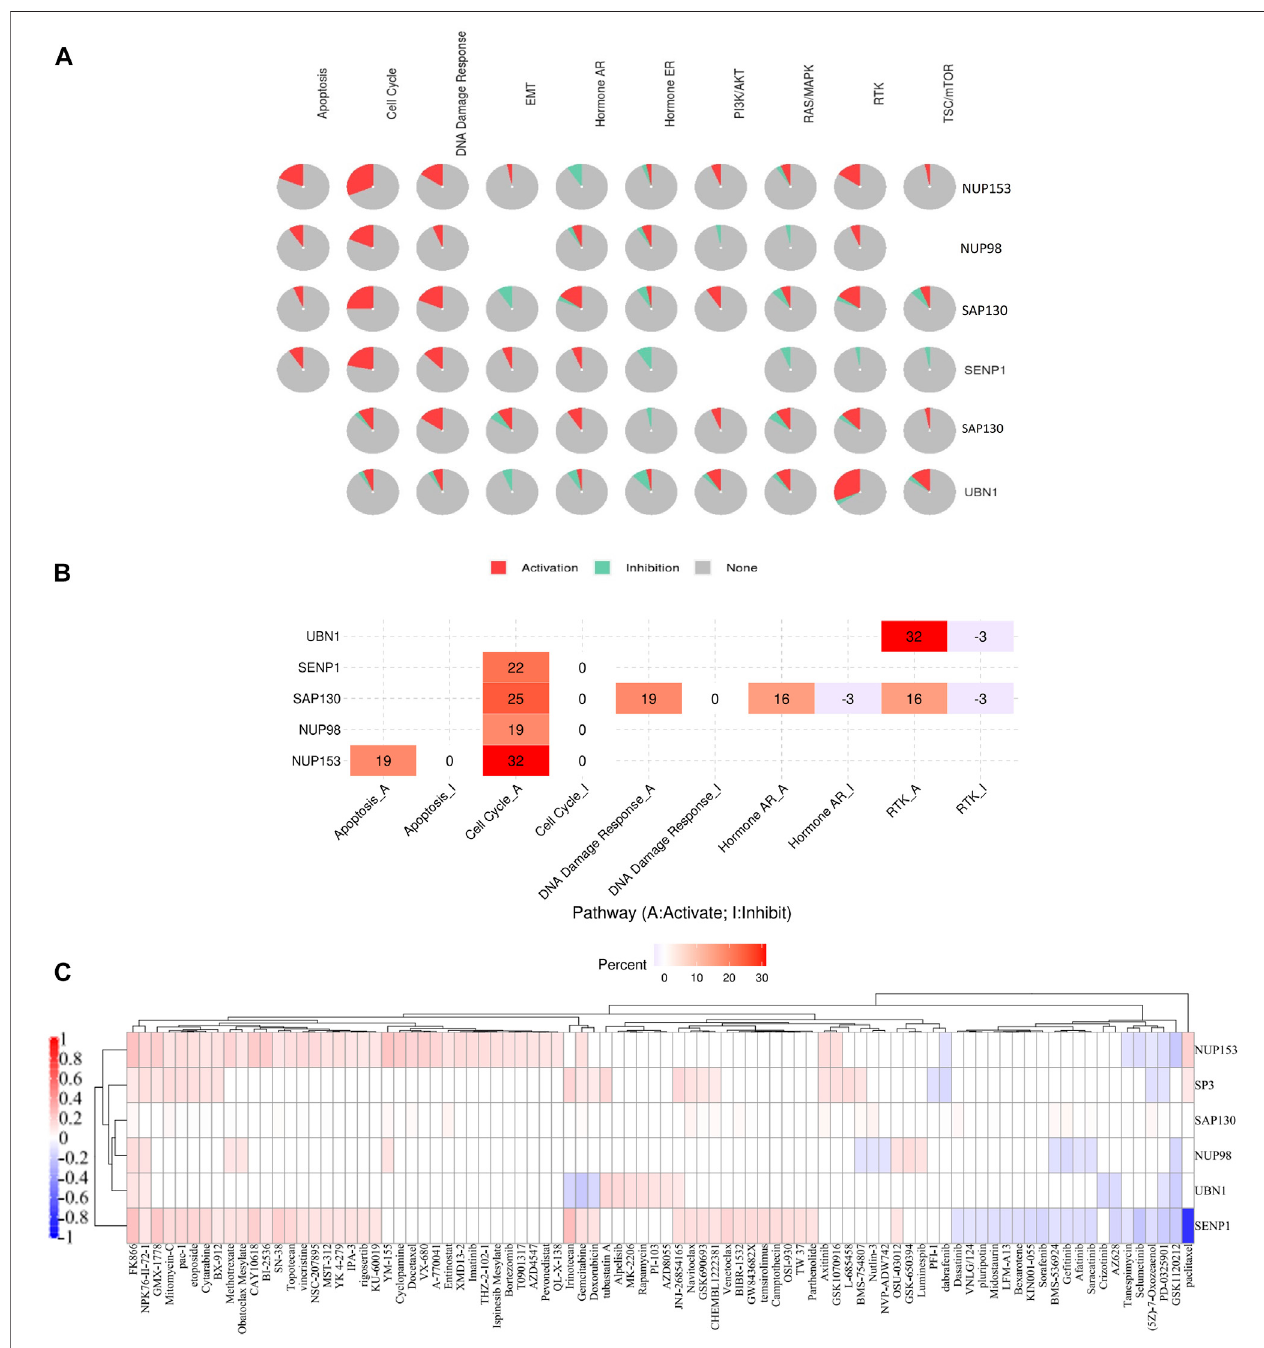
FIGURE 6 | SENP1 network. (A) SENP1-correlated network, (B) Venn diagram of SENP1-binding genes of STRING, and GeneMANIA with SENP1-correlated genes, and (C) Correlation heatmap of common fi ve genes with SENP1 in 32 cancers, (D) Go ontology (BP), and KEGG pathway of SENP1-correlated network.